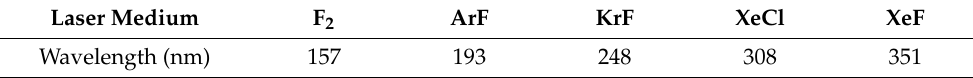
Table 2. Excimer laser gases and